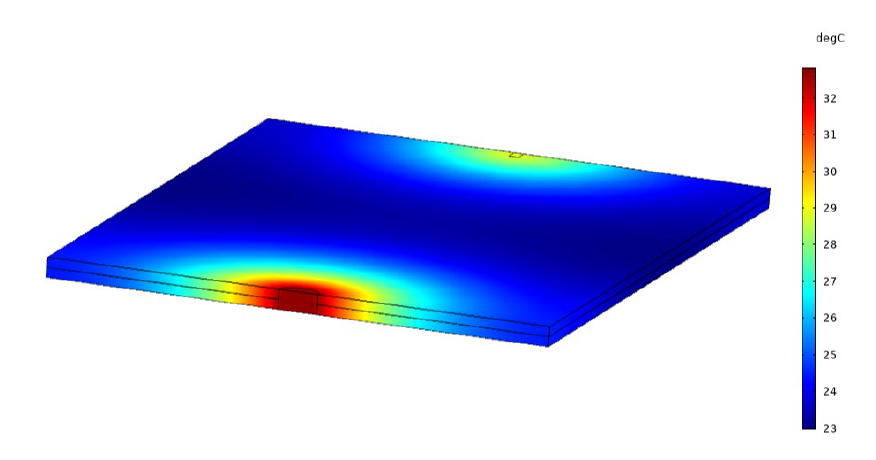
Figure 5. Simulated temperature distribution of the sample at 10